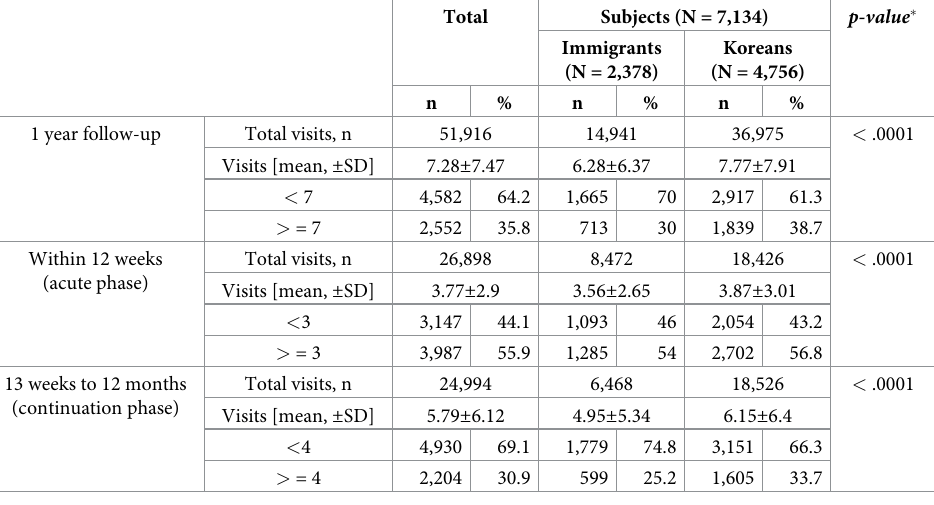
Table 2. The number of outpatient visits in the acute and continuation period (1 year follow up) and the propor- tion of immigrants and Koreans who achieved AOC # for depression